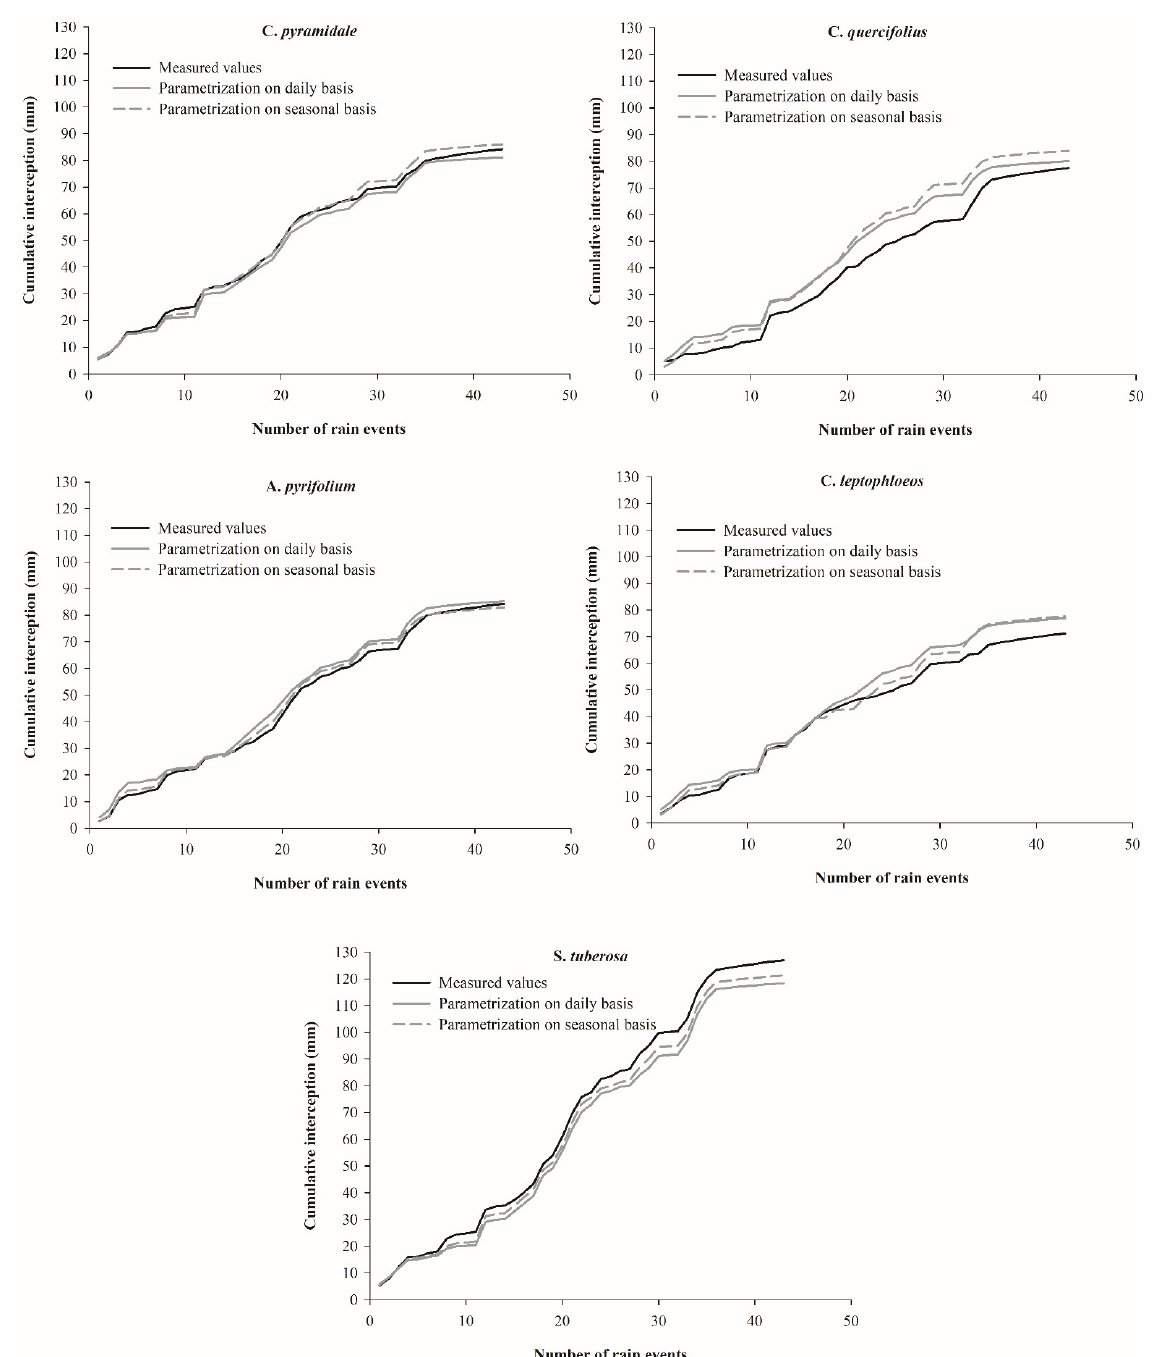
Figure 5. Cumulative measured interception values compared with those estimated by the sparse Gash model parametrized on daily and seasonal bases for each Caatinga species in Brazil.